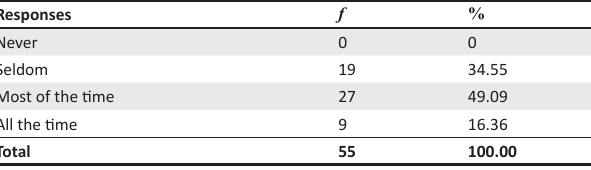
TABLE 7: Respondents’ views on how often community nurses experience poor communication with patients ( n = 55).